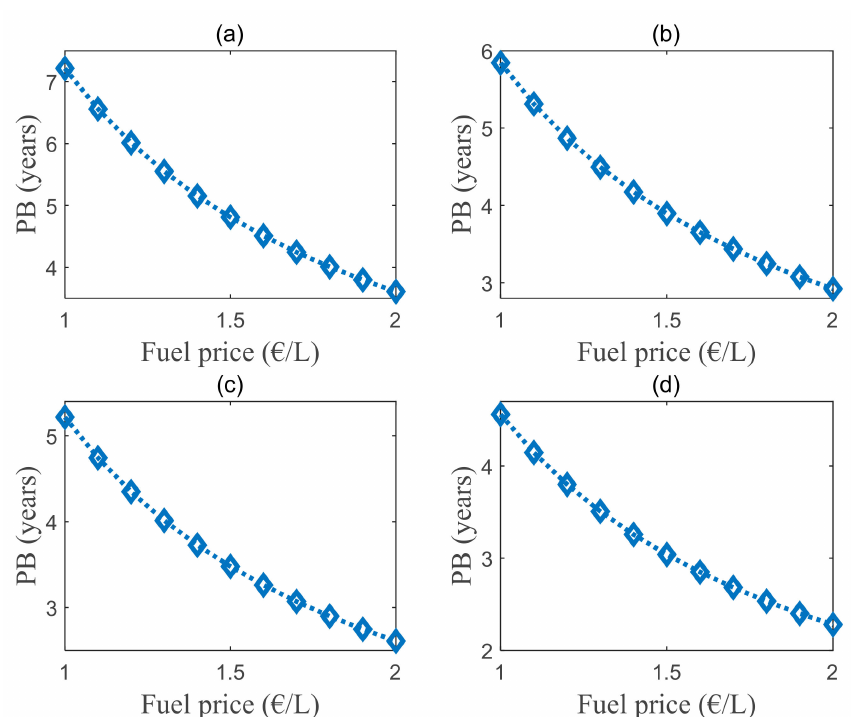
Figure 11. Evolution of the payback period (PB) vs. the fuel price when the daily travel distance is 500 km, the number of working days each year is 255, and the working fluid is ( a ) R245fa, ( b ) R245ca, ( c ) R601a, and ( d ) RC490,